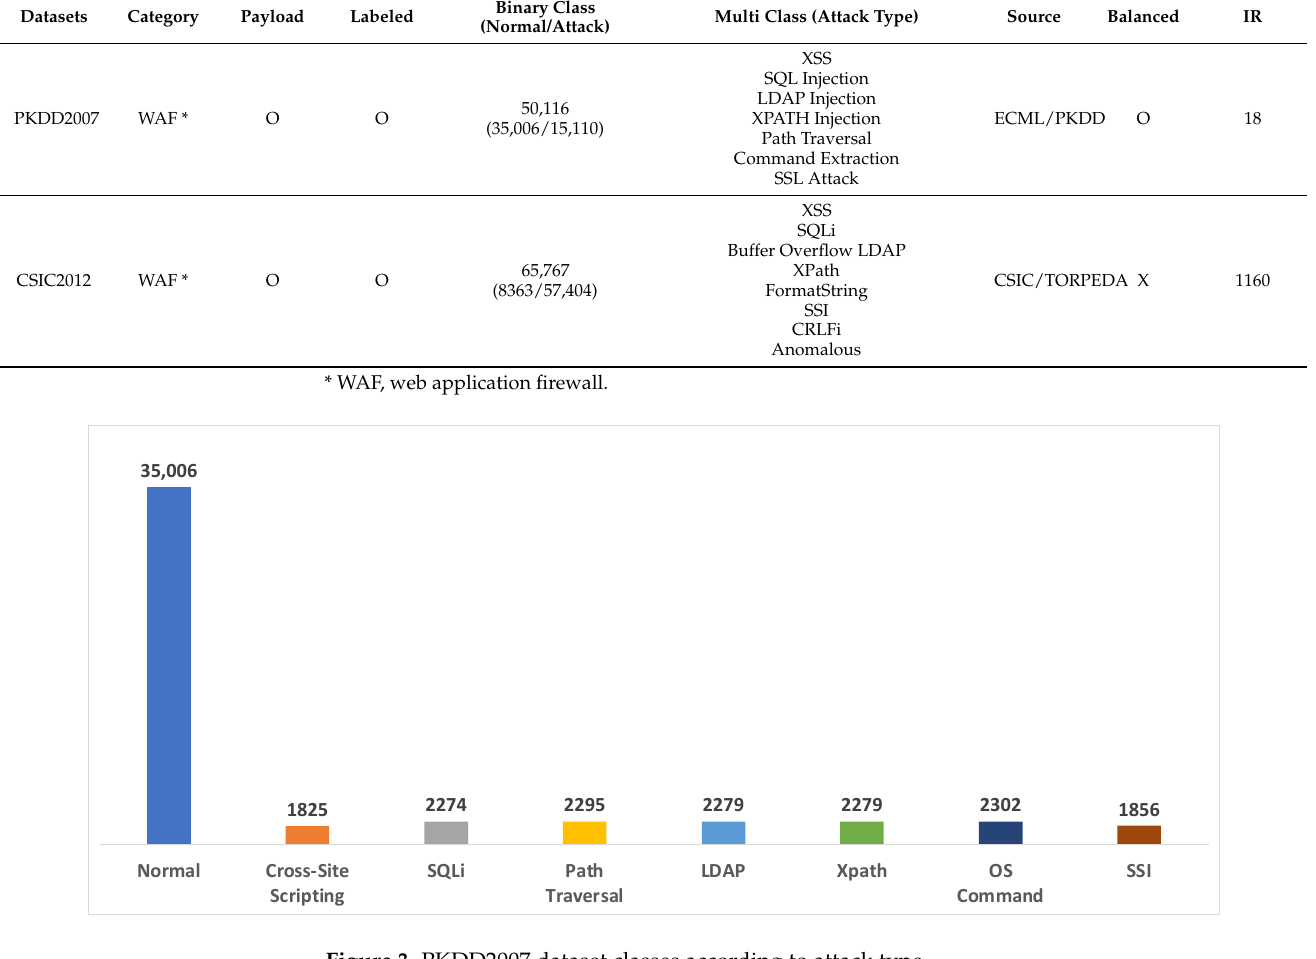
Figure 3. PKDD2007 dataset classes according to attack type.